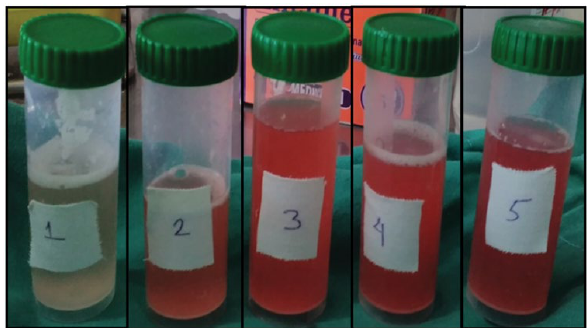
Figure 1A: Chest X-ray showing bilateral alveolar opacities. 1B, C : HRCT showing bilateral areas of consolidation and ground- glass opacities. 1D : HRCT with areas of central ground-glass opacity surrounded by crescentic areas of consolidation, the ‘reverse halo sign’ (arrow) Her Hb was 8.6 gm % and titers of ANA and Anti dsDNA were raised. The serum complement level was low (22 mg/dL). Anti GBM antibody, Anti MPO and Anti PR3 ANCA tests were negative. Urine routine examination revealed 2+ proteinuria with the absence of dysmorphic RBC's. The serum creatinine was 3.2 mg/dL. Bronchoscopic BAL was performed which revealed a progressive increase in the hemorrhagic return in serial aliquots (fig. 2).